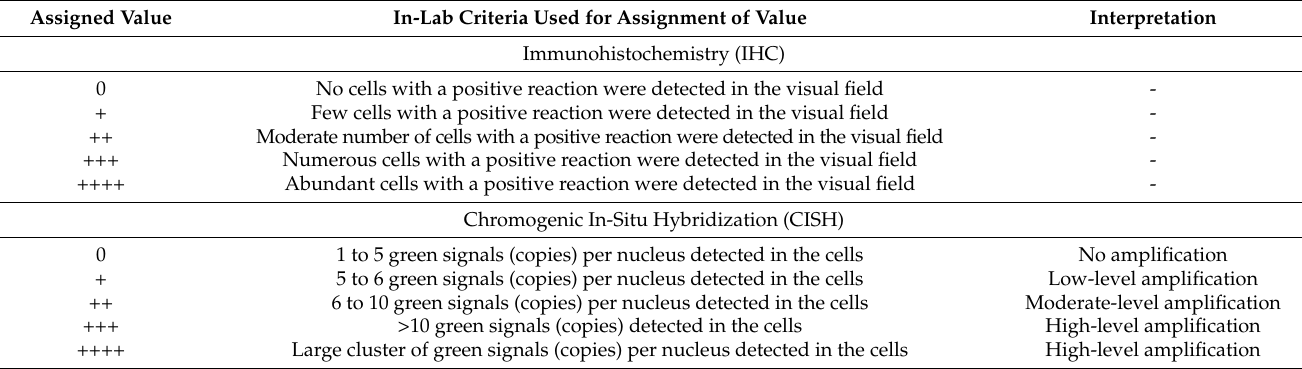
Table 2. Semi-quantitative grading scale used in the present